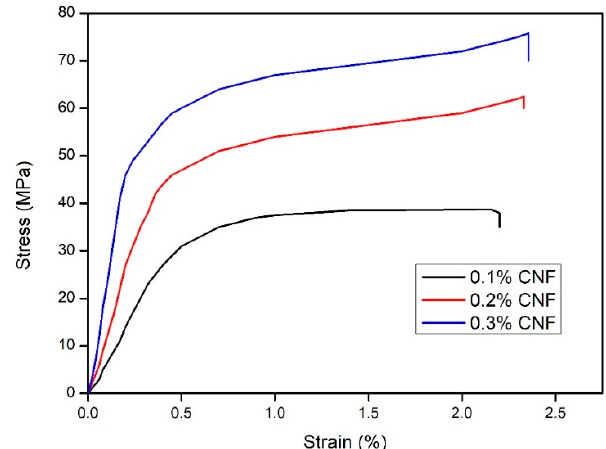
Table 1. Tensile strength of some cellulose nanopapers fabricated via various techniques.